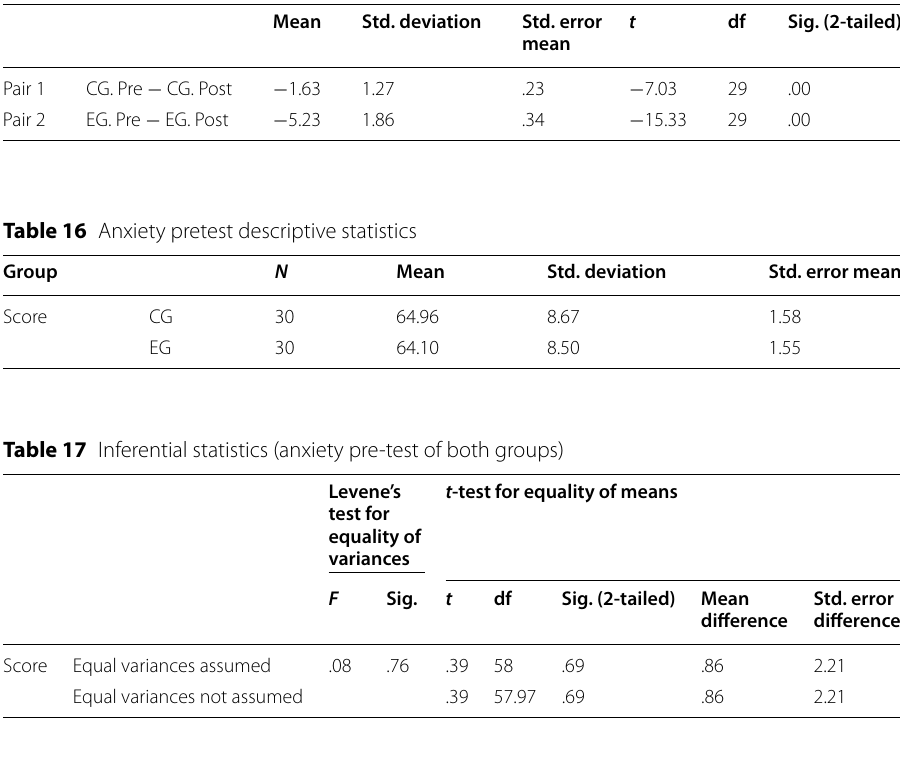
Table 15 Paired samples test (complexity pre‑ and post‑tests of each group) Mean